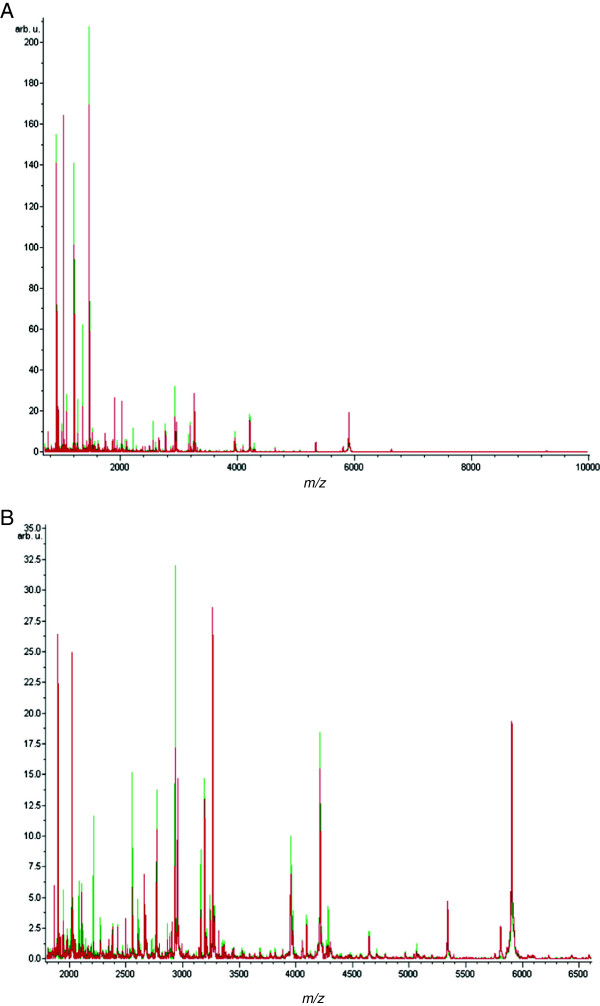
MALDI MS profiling of serum peptides in biliary disease. A. Average MALDI-TOF spectra for BTC (red) and healthy (green) serum samples over the full scan range of m/z 700–10,000. B. Zoomed spectra over the m/z 1,700 to 6,900 range.